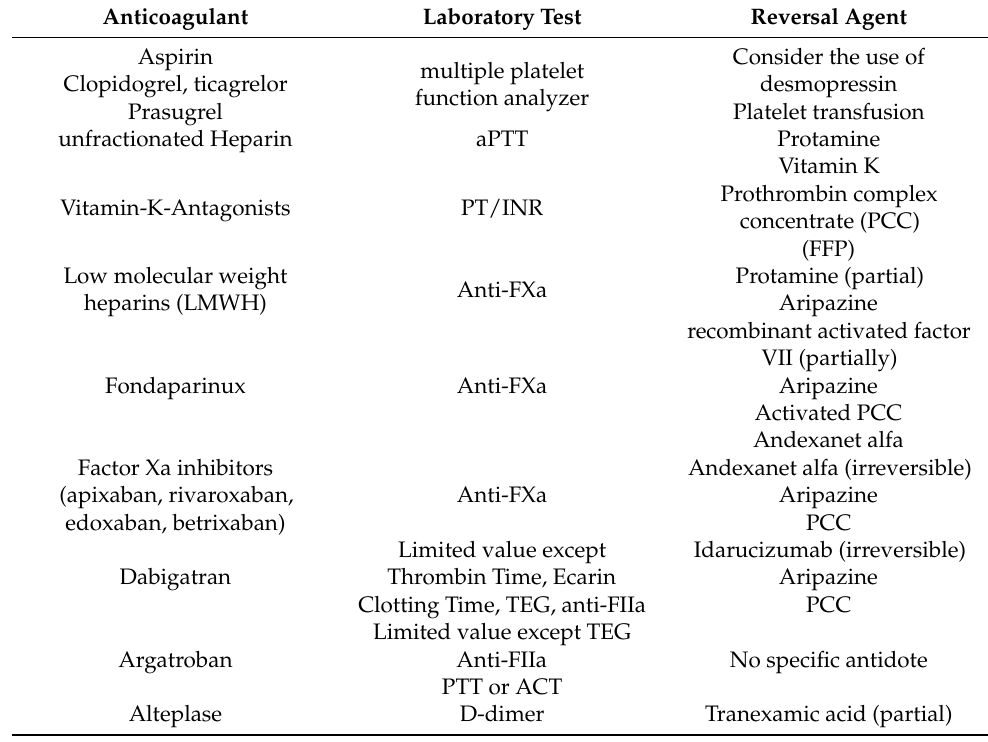
Table 2. Common anticoagulants, diagnostic tests, and their respective reversal agents [29]. Activated partial thromboplastin time (aPTT), prothrombin time (PT), international normalized ratio